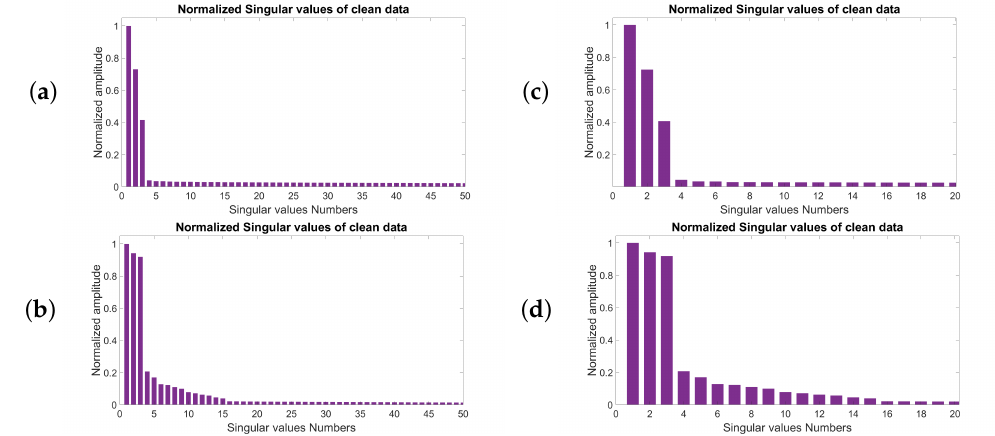
Figure 4. Normalized singular value distribution of the block Hankel matrix of 3-D data with three linear events in the frequency slice: ( a ) 20 Hz, ( b ) 50 Hz. The first 20 singular values of the same data for frequency slice of ( c ) 20 Hz and ( d ) 50